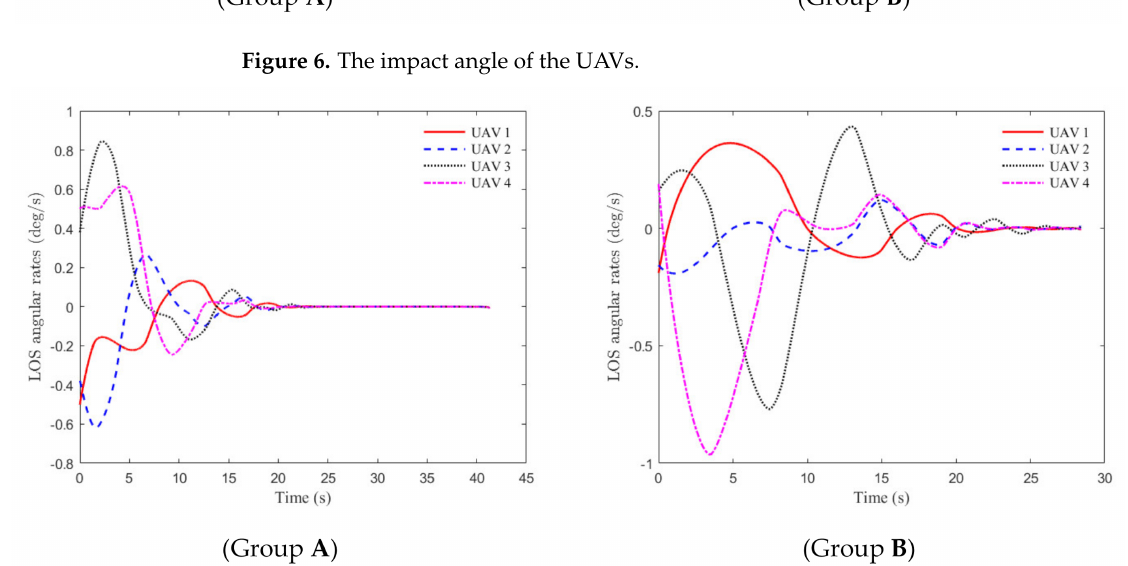
Figure 6. The impact angle of the UAVs.